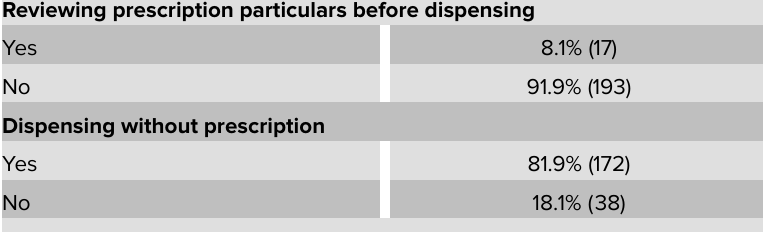
TABLE 3: Dispensing practices observed in